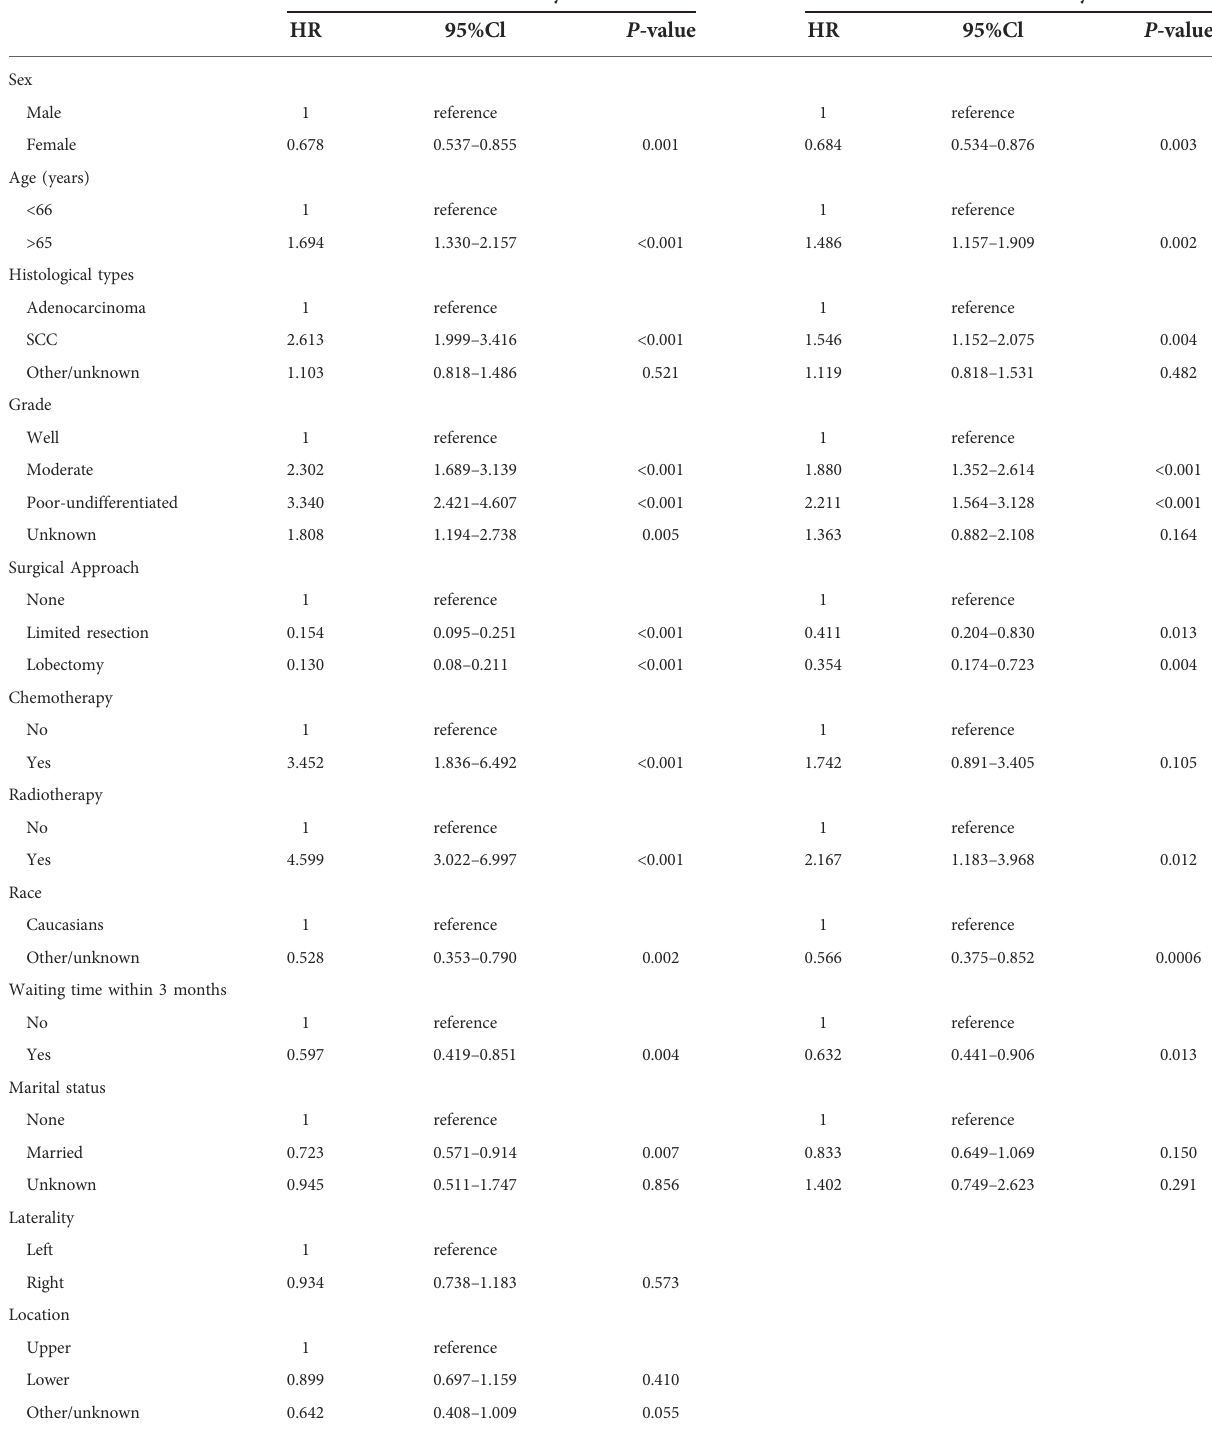
TABLE 2 The univariable and multivariable Cox regression analyses for patients ’ overall